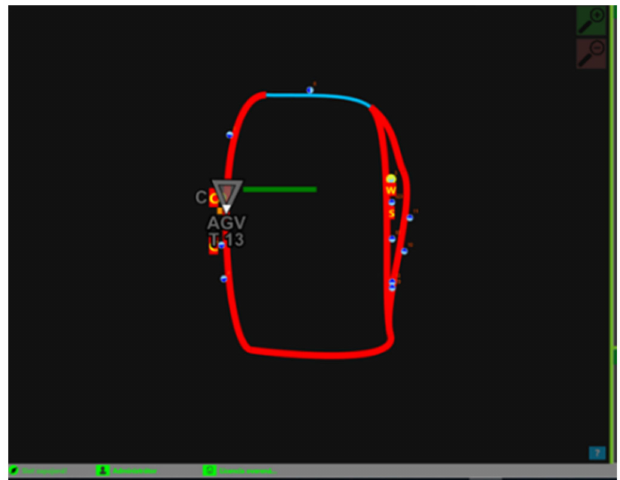
Figure 9. AGV monitor application (processed in the AGV Monitor 3.0 software